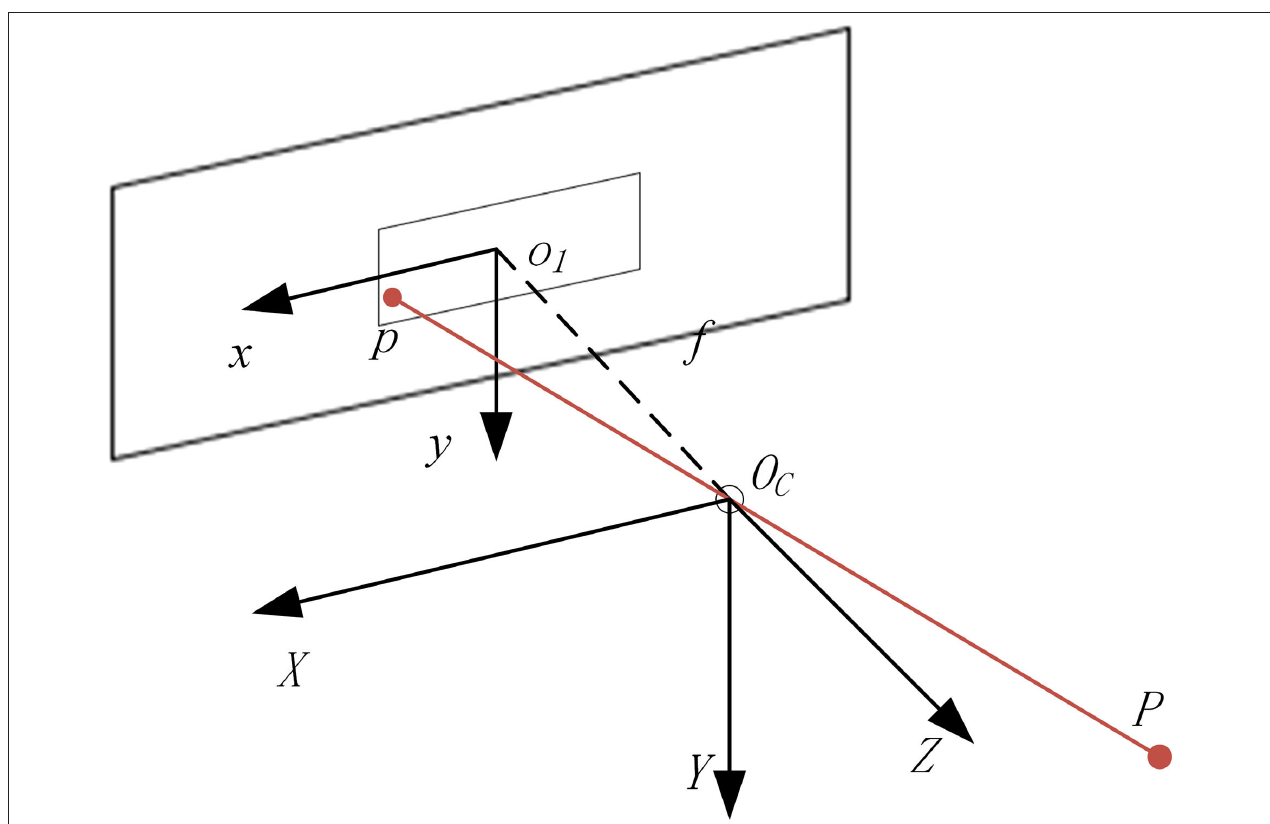
FIGURE 3 | Relationship between the camera coordinate system and image physical coordinate